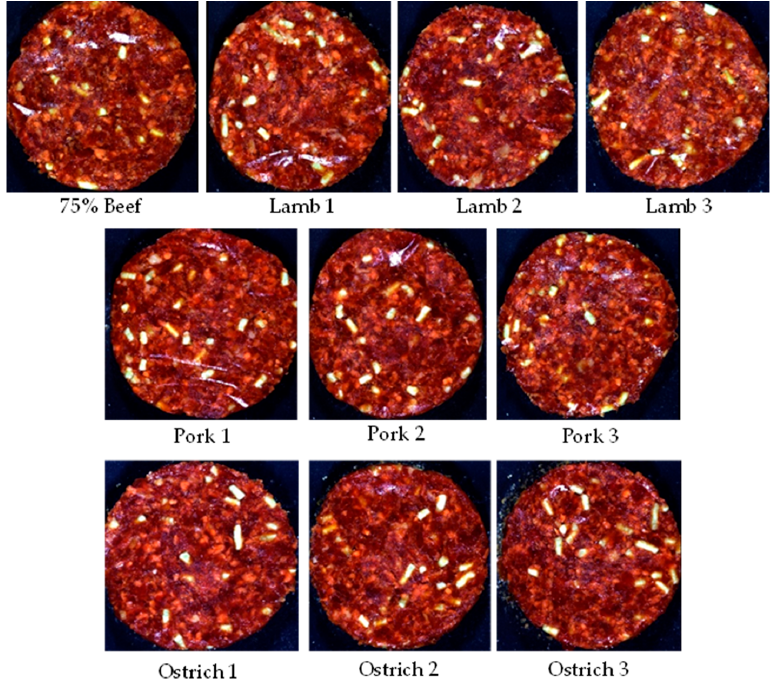
Figure 2. Digital images of the various species substitutions for Patty 2 (burger/patty/hamburger patty/meatball/frikkadel).